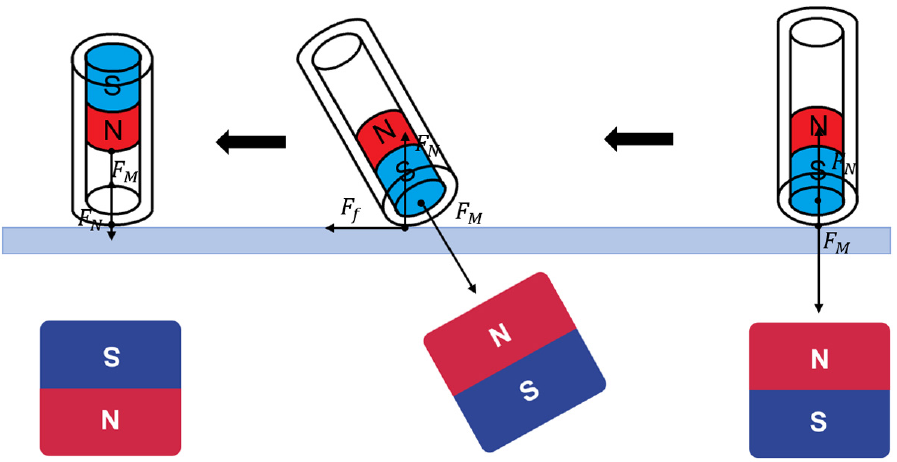
Figure 8. Motion mechanics analysis of tumbling motion. Different morphological forces are experi- enced when the MHCMM undergoes tumbling motion in the side view